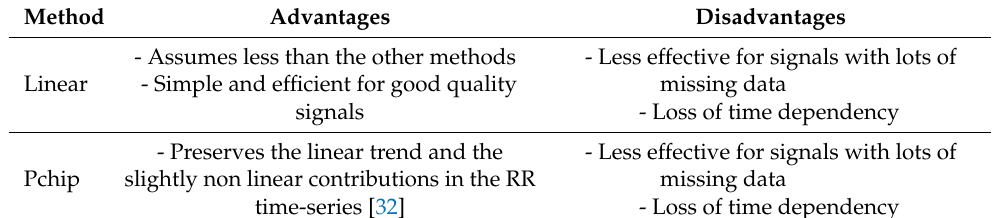
Table 4. Summary table for advantages and disadvantages of data imputation